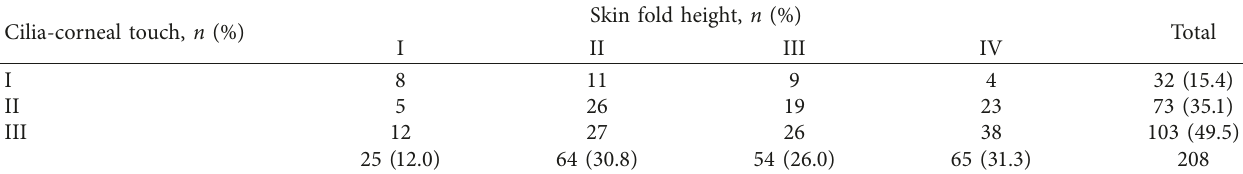
Table 2: Preoperative classification of epiblepharon.